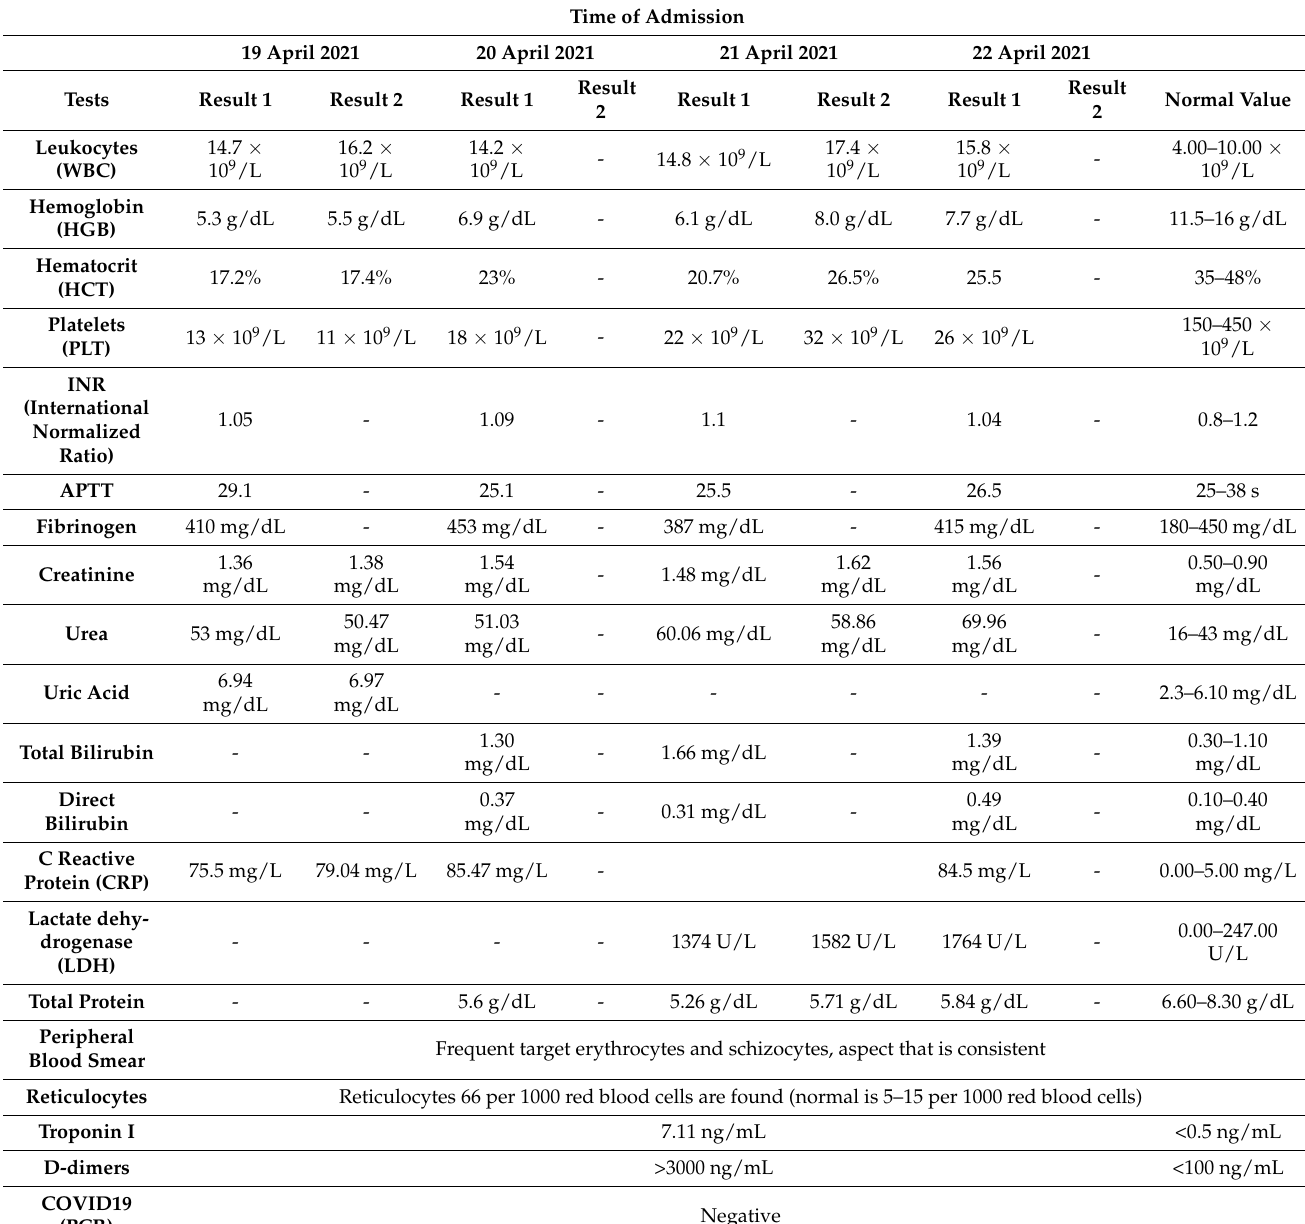
Table 2. Blood tests results per